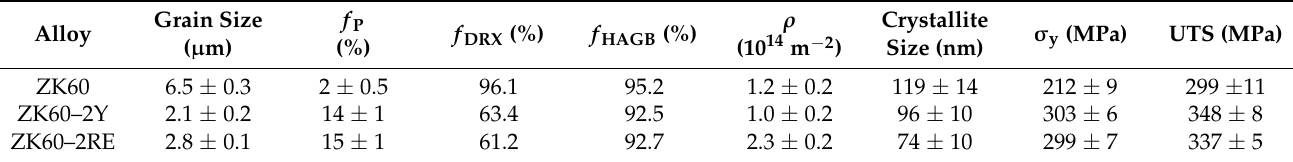
Figure 1. SEM images for ( a ) ZK60, ( b ) ZK60–2Y, and ( c ) ZK60–2RE alloys. The bright areas in the SEM images correspond to the secondary phase particles. The red arrows and the letters A, B and C show the locations where the EDS analysis was performed. The corresponding EDS spectra are shown in Figure 2. Color-coded EDS elemental maps for ( d ) ZK60–2Y and ( e ) ZK60–2RE alloys (Mg: orange, Zn: red, Y and Ce: turquoise). Table 1. Microstructural characteristics and mechanical properties of the three studied alloys ( f P : fraction of secondary phase particles as obtained by SEM; f DRX : fraction of recrystallized volumes determined by EBSD; f HAGB : HAGB fraction obtained by EBSD; ρ : dislocation density determined by XLPA; UTS: ultimate tensile